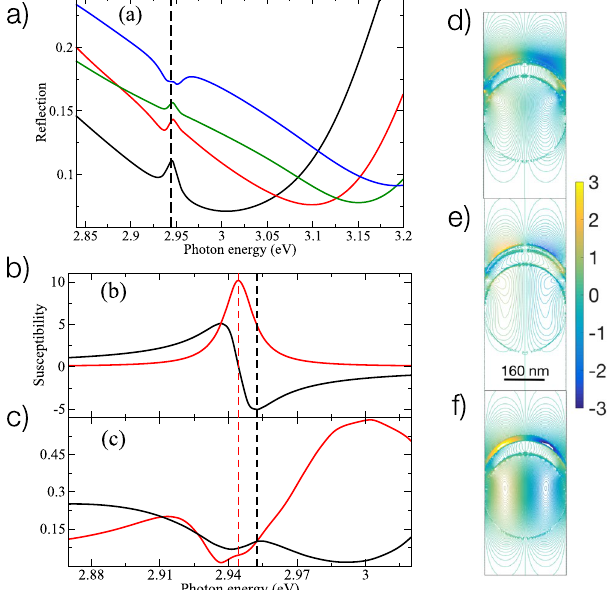
Figure 4. Results of numerical modeling II. Panel (a) shows the reflection spectra calculated at different periods of the opal array. The molecular density is 10 25 m − 3 . Black line shows results for the period of 310 nm, red line is for 300 nm, green line is for 290 nm, and blue line shows data for 280 nm. Panel (b) shows the molecular electric susceptibility, χ M , calculated at the molecular density of 3 × 10 26 m − 3 . The black line shows the real part of χ M , the red line shows the imaginary part of χ M . The vertical red dashed line indicates the molecular transition energy (corresponding to the maximum of Im ( χ M ). The vertical black dashed line shows the energy corresponding to the minimum of Re ( χ M ). Panel (c) shows transmission (black line) and reflection (red line) for the period of 320 nm and molecular density of 3 × 10 26 m − 3 . Panels (d–f) show spatial distributions of the longitudinal component of electric field, E z , normalized with respect to the incident field amplitude. The incident field excites the system along x (horizontal axis in each panel) axis propagating from top to bottom of the panels. Panel (d) shows E z for the lower polariton mode calculated at the energy 2.86 eV. Panel (e) shows E z at the energy of the third mode, namely 2.94 eV. Panel (f) shows E z at the energy of the upper polariton 3.04 eV. The plane of calculations is at y = 0. Other parameters of the simulations are: the diameter of polystyrene spheres is 320 nm, the molecular concentration is 2 × 10 26 m − 3 , the molecular transition dipole moment is 10 Debye, the radiationless lifetime of the excited state is 1 ps, and the pure dephasing time is 730